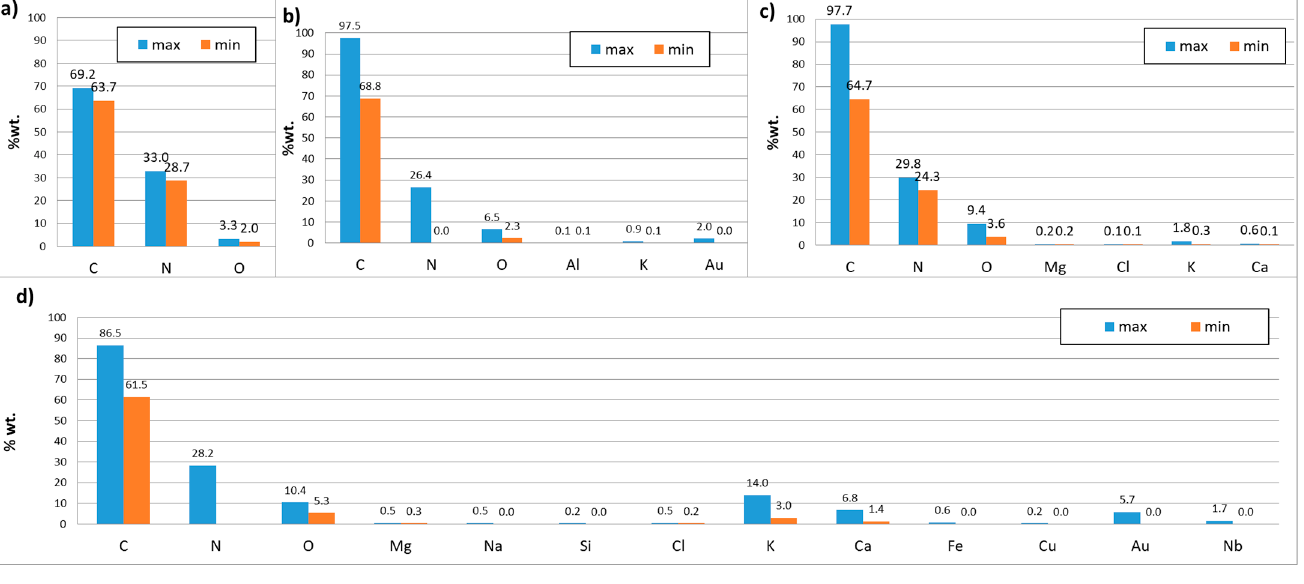
Figure 7. EDS analyses of “as-spun” fibers, and mass percentages of the detected elements: ( a ) 100% PAN; ( b ) 90% PAN-10% biochar; ( c ) 75% PAN-25% biochar; ( d ) 50% PAN-50% biochar.